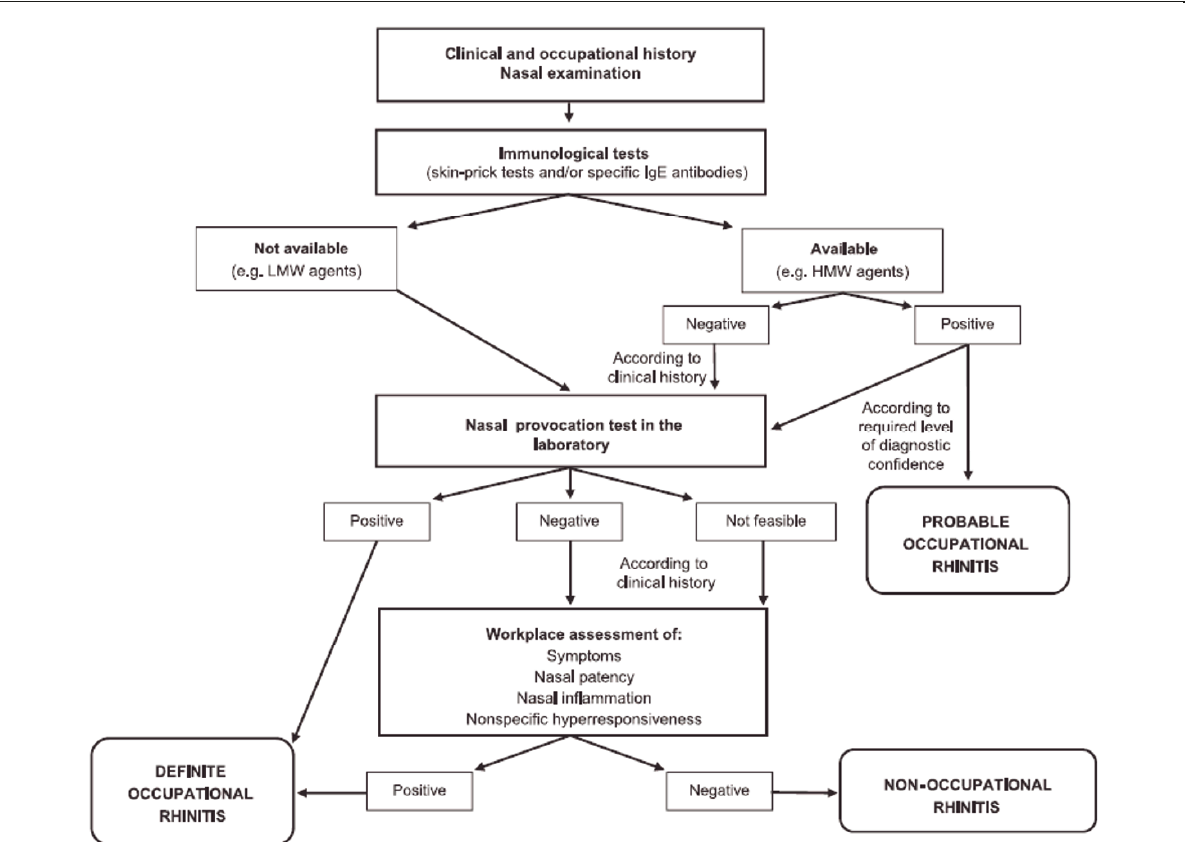
Figure 18 Diagnostic algorithm for occupational rhinitis